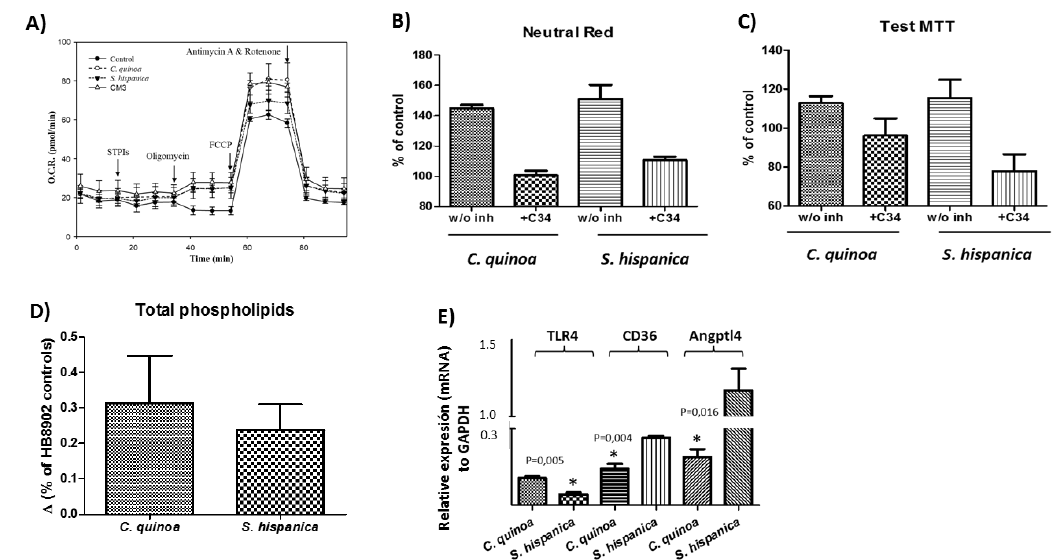
Figure 3. Metabolic changes in HB8902 © cells incubated (3 h) with extracts from C. quinoa or S. hispanica L. ( A ) Typical profiles of changes in oxygen consumption rates (OCR, pmol O 2 / min) (n = 6). ( B ) neutral red uptake due to endo / lysosomal activities (n = 4). ( C ) MTT conversion by mitochondrial dehydrogenases (n = 4). ( D ) Serine-type protease inhibitors-induced changes on total phospholipids content in human-like macrophages (HB8902) cells (n = 4). ( E ) Differential gene expression (mRNA) of Toll-like receptor 4 (TLR4), translocase of fatty acids (CD36) and angiopoietin-like 4 protein (Angptl4) (n = 4). * Indicates statistically significant ( p < 0.05) differences in relation to its counterpart.